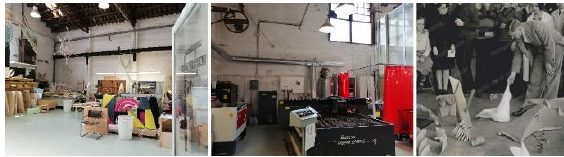
Figure 12. Two ateliers of IAAC (Photos by the author) and a workshop at Bauhaus (Albers,